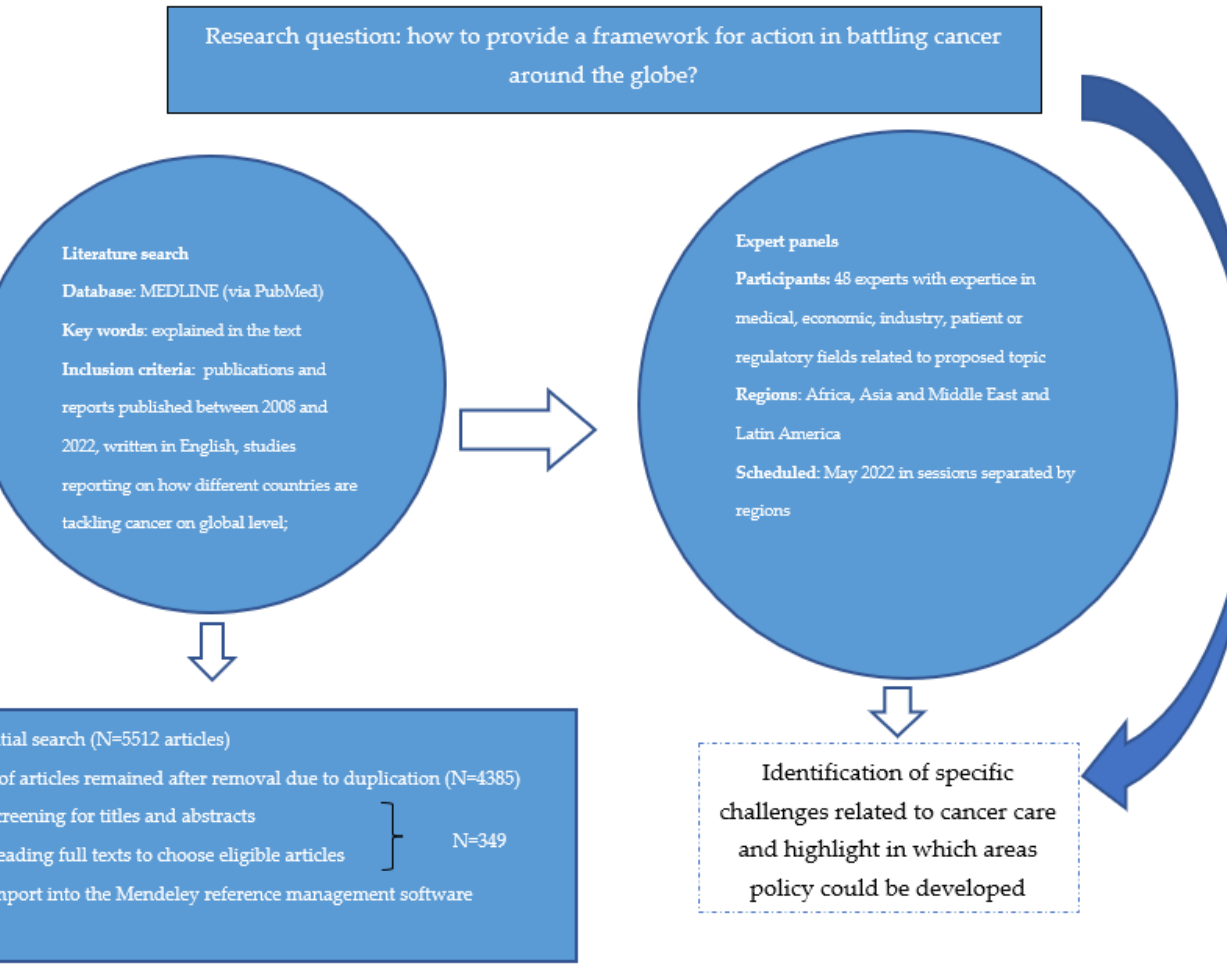
Figure 1. Research strategy applied. Methodology used to provide policy framework for tackling cancer on the global level.